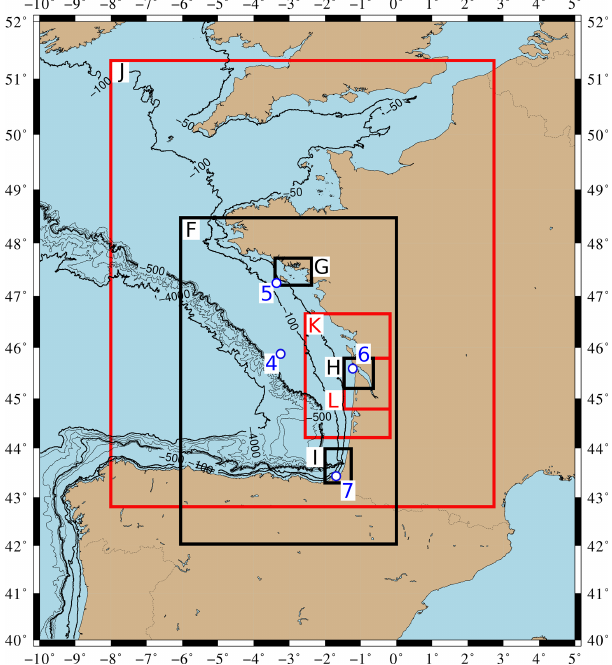
Figure 5. Computational domains for Calypso at 500m (F), 125m (G) and 32.5m (H and I) resolutions in black and FUNWAVE- TVD at 450m (J), 110m (K) and 20m (L) resolutions in red. After the − 50m contour, bathymetric contours range from − 100 to − 500m every 100m and then from − 1000 to − 4000m every 1000m. Gauges 4, 5, 6 and 7 are marked by the white and blue